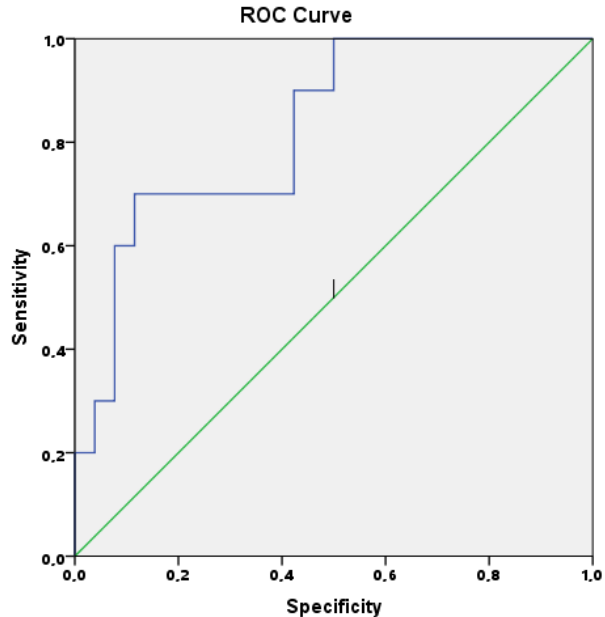
Figure 2. Receiver operating characteristic curve of baseline serum level of CXCL10/IP10.